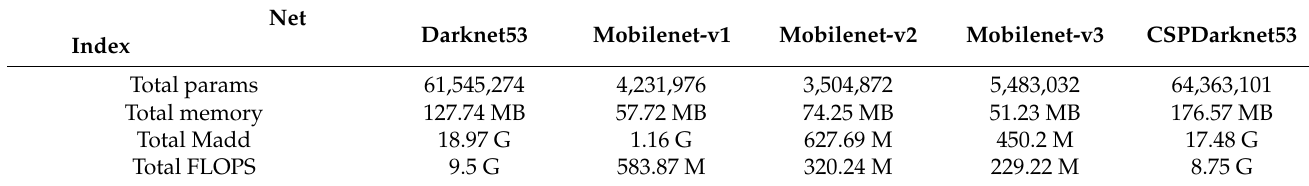
Table 7. Comparison of the calculation consumption of the five network structures.